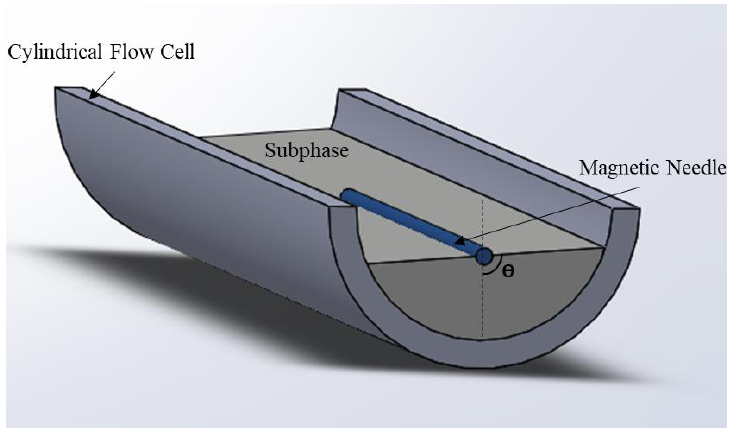
Figure 8. Schematic diagram of the oscillating needle device used for interfacial rheology.